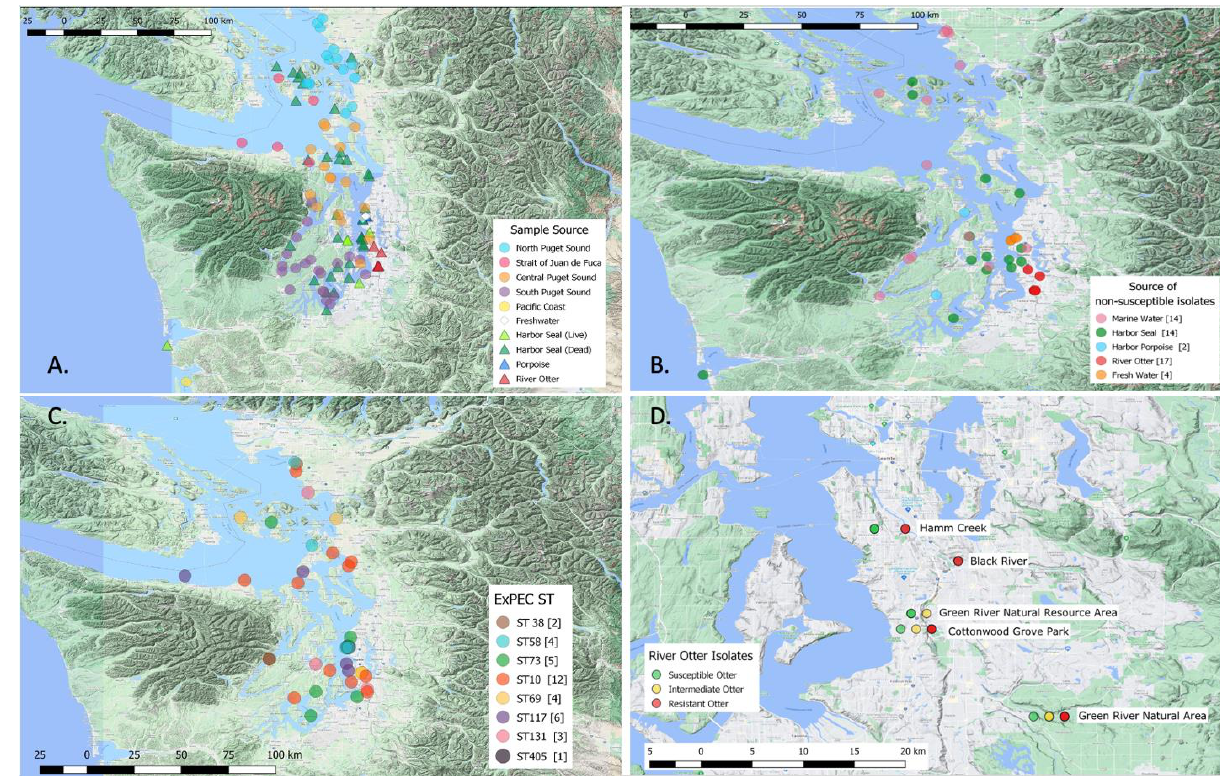
Figure 1. Maps of ( A ): all E. coli isolates by sample source; ( B ): resistant and intermediate E. coli isolates by sample source; ( C ): ExPEC STs of E. coli by location; ( D ): river otter E. coli isolate results.